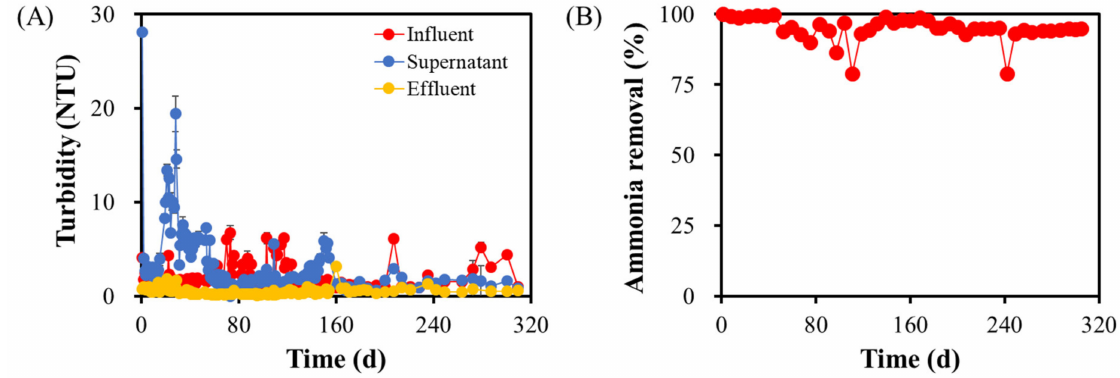
Figure 4. Turbidity in the influent, supernatant, and effluent ( A ) of the GMBR, as well as the ammonia removal ( B ) in the course of 305 days of operation. The error bar refers to the standard deviation from triplicate